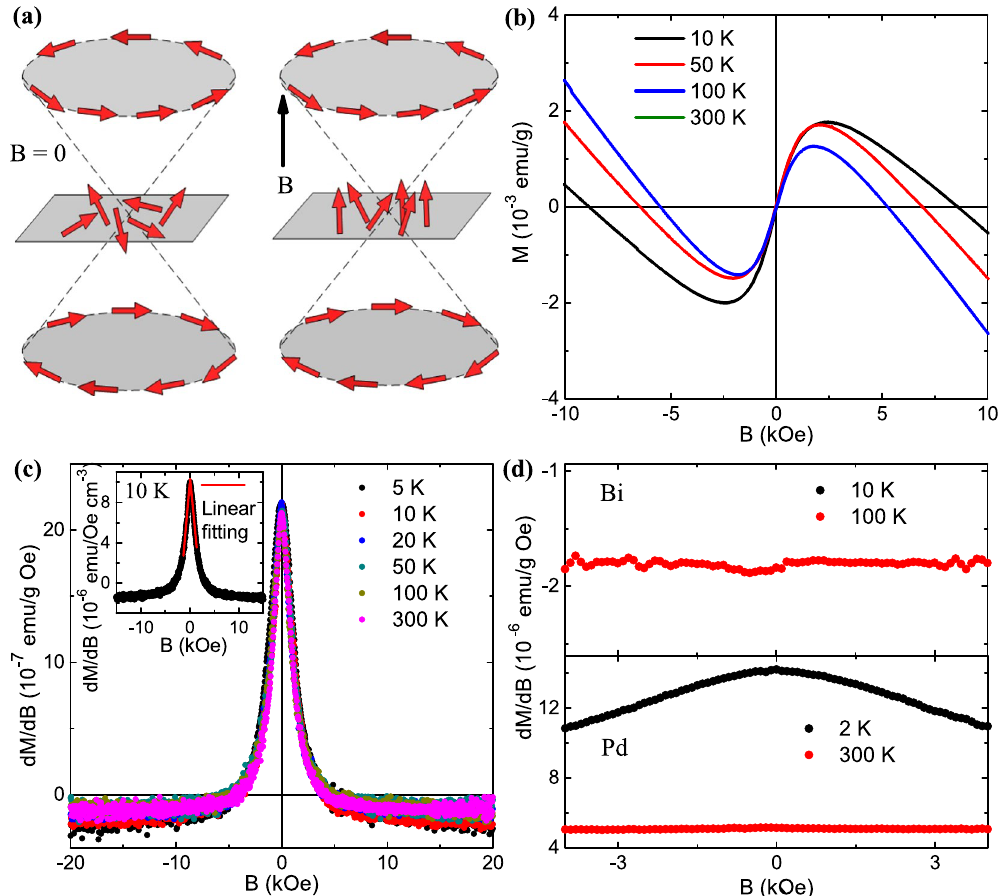
Figure 5. Paramagnetic singularity in magnetization measurement for LaBi. ( a ) Schematic representing the helical spin-texture of surface Dirac cones for a 3D topological insulator without and with magnetic field. The arrows indicate the direction of the electron spins. ( b ) Low field region of the magnetic moment vs. B curves at different temperatures for LaBi. ( c ) Magnetic susceptibility χ ( = dM / dB ), calculated by taking first order derivative of magnetic moment, plotted as a function of magnetic field. Inset shows the linear field decay of χ . ( d ) Magnetic susceptibility of standard Bi and Pd